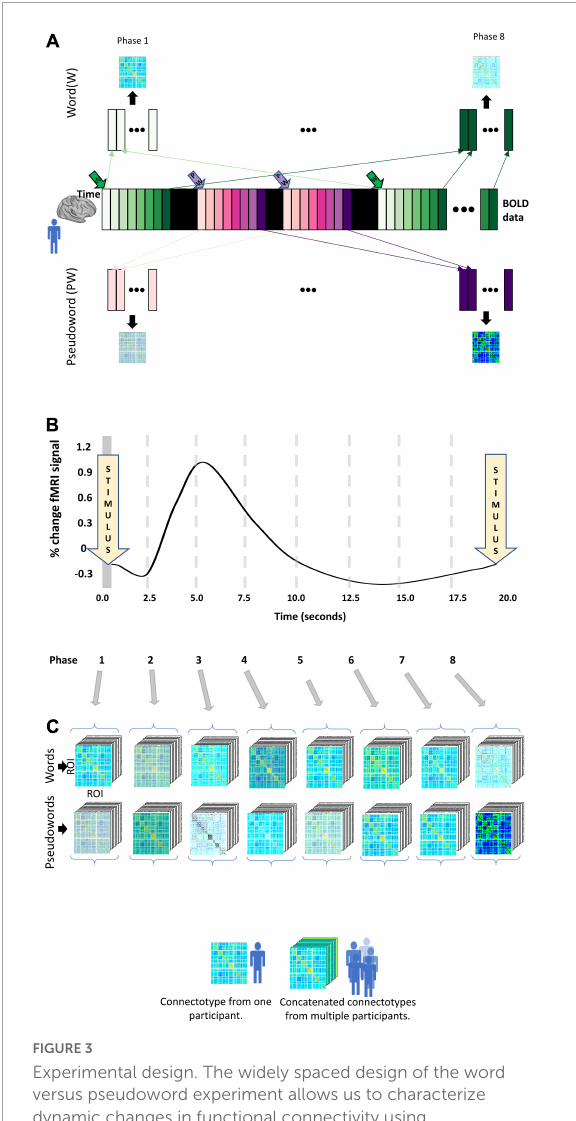
FIGURE3 Experimental design. The widely spaced design of the word versus pseudoword experiment allows us to characterize dynamic changes in functional connectivity using connectotyping. (A) The collected whole-brain BOLD data is represented as the central colored strip. Each bar corresponds to data acquired at each TR and is color-coded according to the stimuli (Green for “Word” and purple for “PW”). A word or pseudoword is displayed for 2.5 s with no new stimuli after 20 s. The bars in black represent “catch” trials. Frames collected at the same time, relative to the exposure to the stimuli, are concatenated to create a stack of frames of size 333 times replica frames. Those frames are used to calculate a connectivity matrix. This approach generates 16 connectivity matrices per participant. (B) Temporal evolution of the theoretical hemodynamic response. (C) Resulting connectotypes from each participant (A) are grouped according to their phase and stacked with the connectotypes of all the participants included in the study.